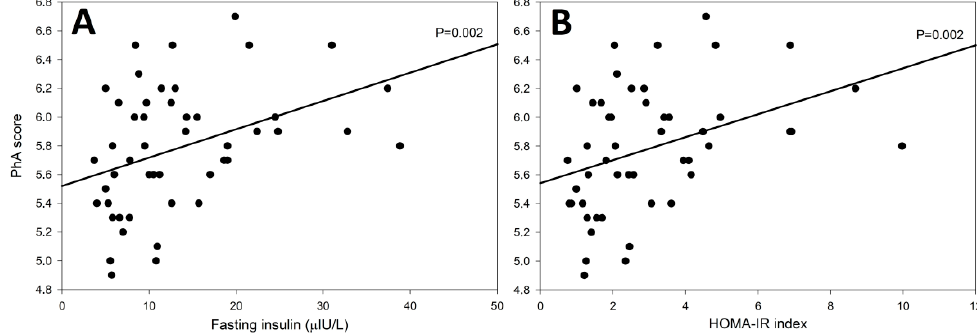
Figure 3. Linear correlation between phase angle (PhA) score and fasting insulin level ( A ), and with HOMA-IR value ( B ) in women with Hashimoto’s thyroiditis: scatter plot and regression lines.